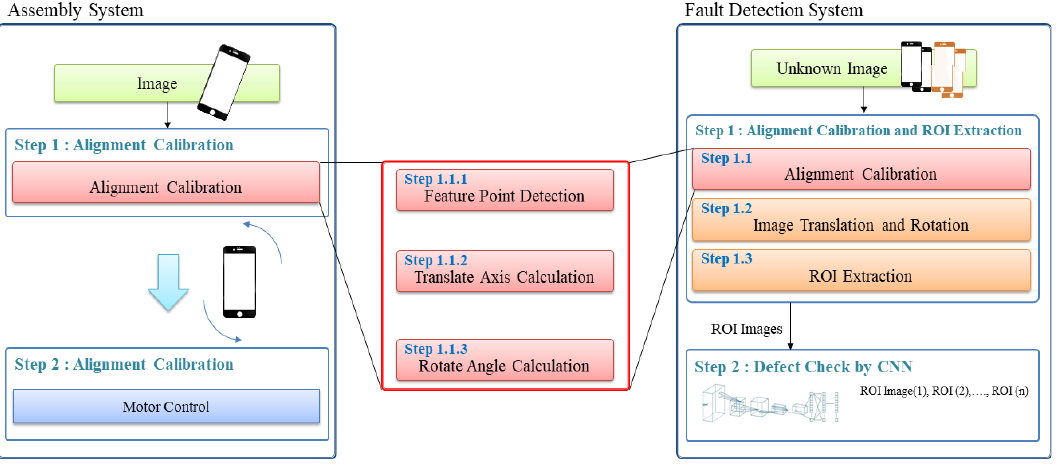
Figure 3. Detailed structure of the product assembly process and defect detection system. 3. Circle-Based Reference Point Extraction Method for the Correcting the Alignment of Round